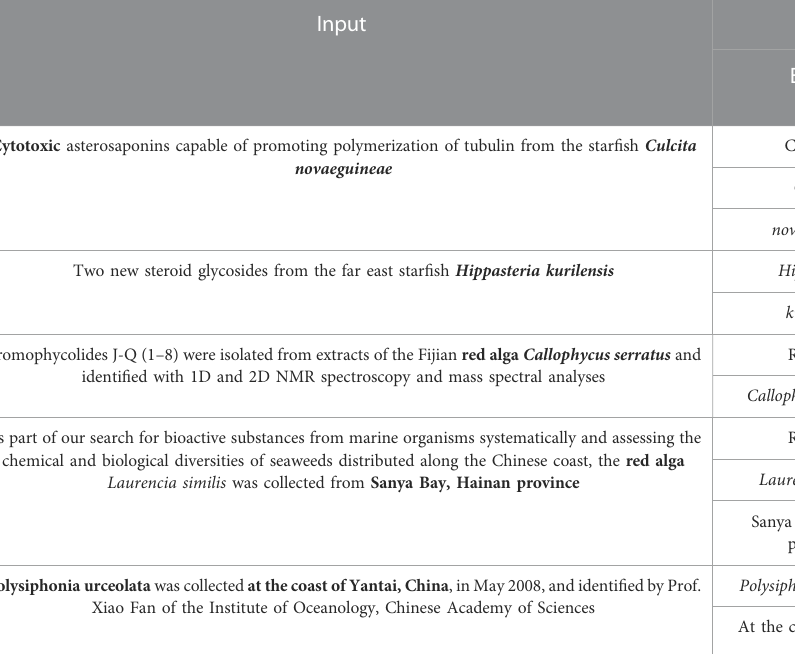
TABLE 2 Test input and output sample table.